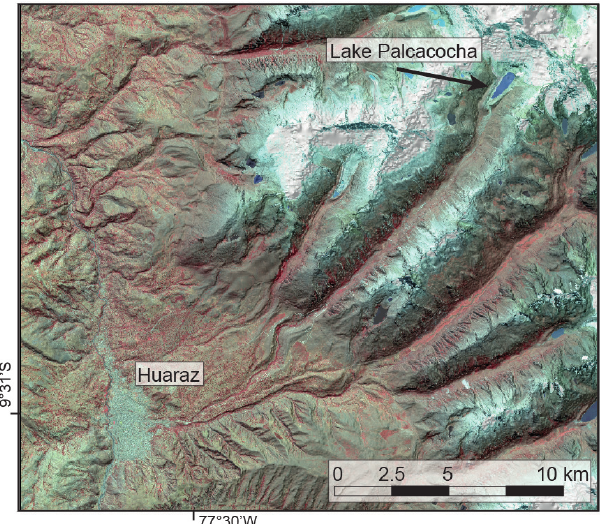
Figure 1. Study region with lake Palcacocha and the city of Huaraz (source: SPOT image; year of acquisition: